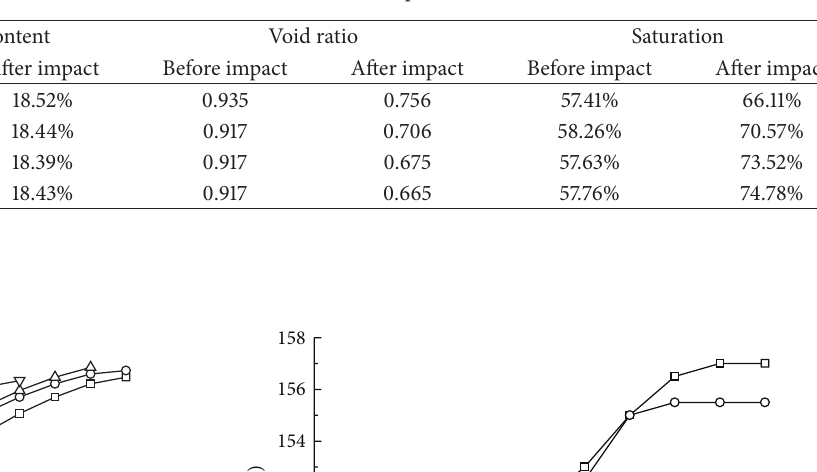
Table 6: Void ratios and saturation of soils below the impacted holes.